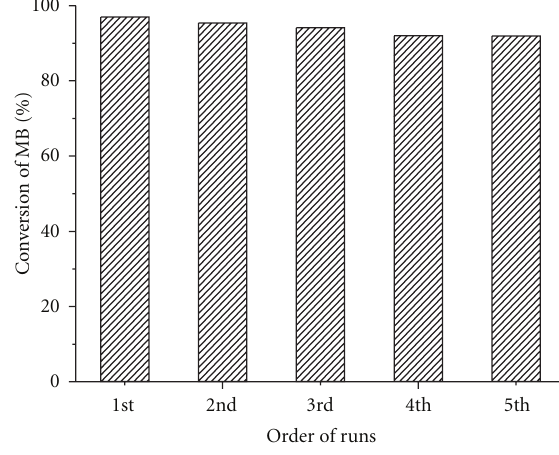
/ 3 Figure 7: Cycling runs for the photodegradation of methylene blue on AgBr/TiO 2 ( m AgNO